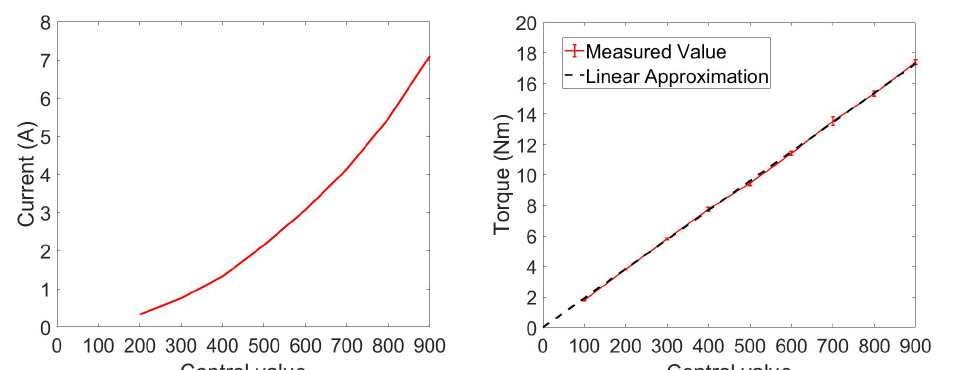
Figure 2. Actuator test setup.